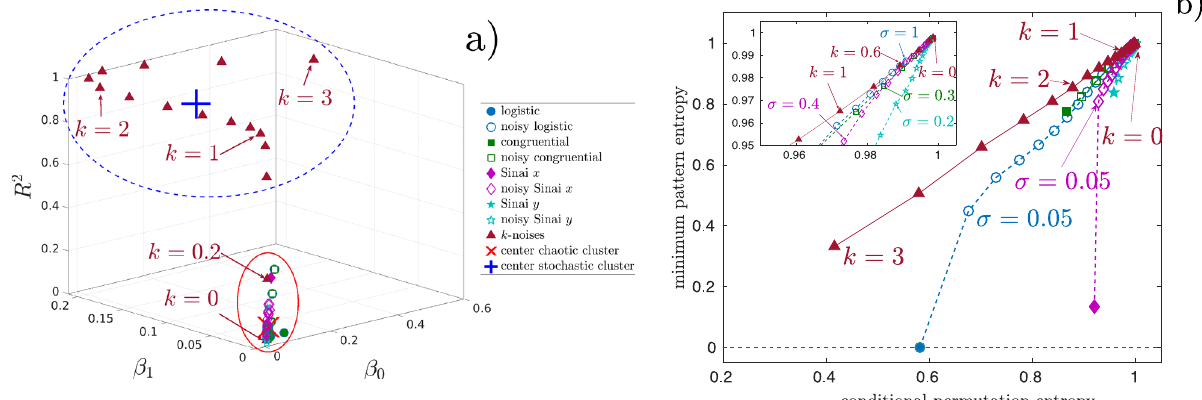
Fig. 5 Ordinal transition approaches. a Clustering representation of the triplet { β 0 , β 1 , R 2 } ( β 0 and β 1 being parameters of the model applied to p st ( τ ) de fi ned in ref. 48 and R 2 stands for the error of the fi tted model) and b minimum pattern entropy versus conditional permutation entropy for k -noises ( k ∈ [0, 3] with step 0.2) and chaotic maps with additive noise with σ ∈ [0, 1] with step 0.05. Results in b were obtained by using 10 6 data points to have a reliable contrast. Noise-free sequences (solid symbols). Noisy sequences (open symbols). k : correlation degree and σ : intensity of the noise contamination.